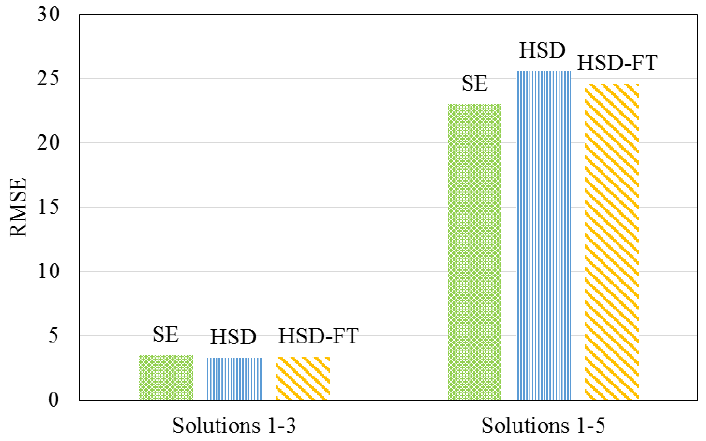
Figure 6. Comparison of models for describing permeate magnesium concentration.